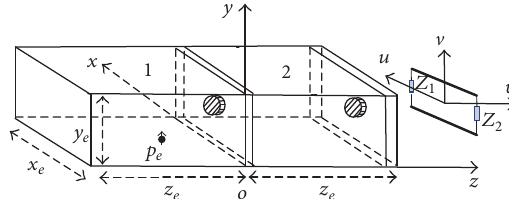
Figure 2: The equivalent lumped-T circuit model of TL. model).